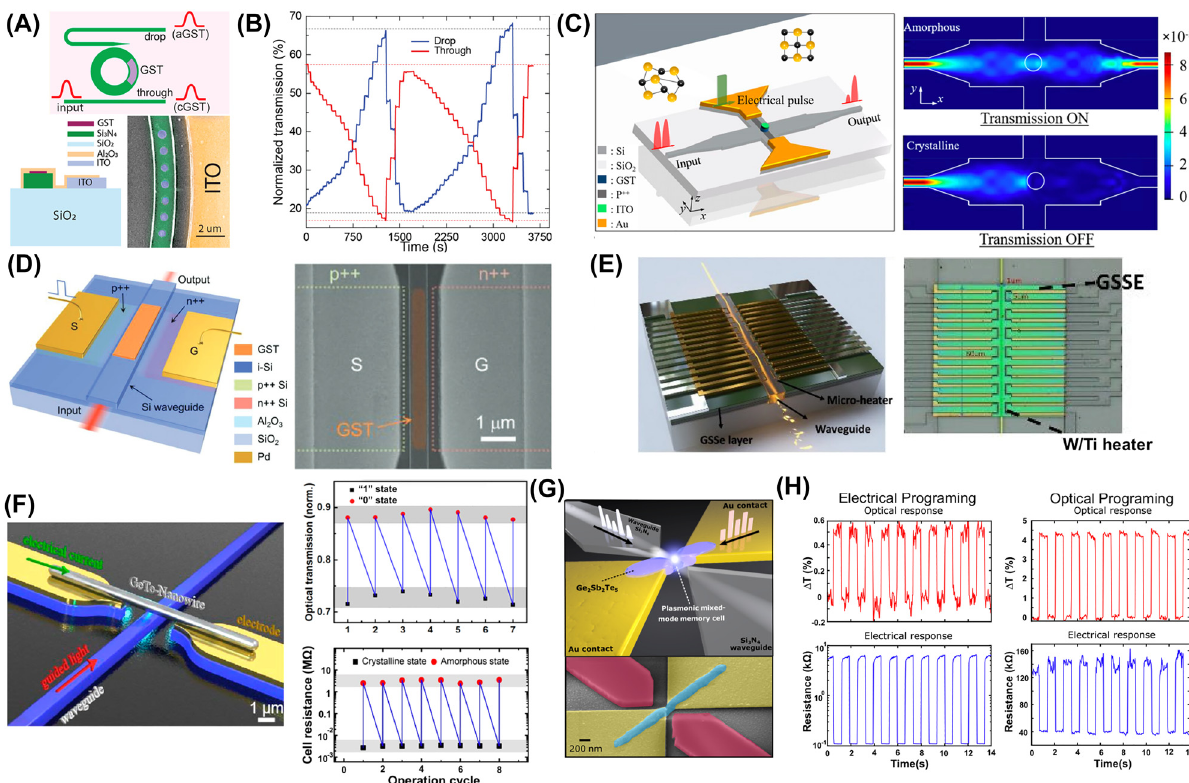
Figure 5: Electrothermal and mixed-mode switching of PCM-integrated memory devices. (A) and (B) Low-loss 1 × 2 optical switch by integrating patternedGST to a ring resonator[64]. (A) Top: Operation principle of the 1 × 2 optical switch. Bottom left: Cross-sectional view of the device structure. Bottom right: False colored top-view SEM image of the subwavelength sized GST disks. (B) Real-time transmission measurementduringtwofullcyclesofswitching.(C)DemonstrationofanelectricallydrivenopticalmemristiveswitchbasedonGSTintegrated MMI[66].Left:Schematicofthedevicedesign.GSTdiskisencapsulatedandplacedatthecenteroftheMMI.Right:FDTDsimulationsshowing the power distribution as light propagates through the MMI when the GST disk is amorphous(Top) and crystalline (bottom).(D) Device design of an electrically recon fi gurable photonic switch usinga PIN diode heater [67]. (E) Optical image showingpaired W/Ti heaters placed in series along both sides of the waveguide to electrothermally switch GSSe and realize 4 × 1-bit memory [68]. (F) Demonstration of mixed-mode read-outin GeTenanowireembeddedoptoelectronic circuits[69]. Left: Illustration of devicedesign.Optical transmission contrast(Top Right) and electrical resistance contrast (Bottom Right) both realized in the optical domain. (G) and (H) Plasmonic nanogap enhanced GST-based memory cell [70]. (G) Schematic of the device zoomed in at the nanogap. (H) Device ’ s optical and electrical response under electrical programing (Left) and optical programing